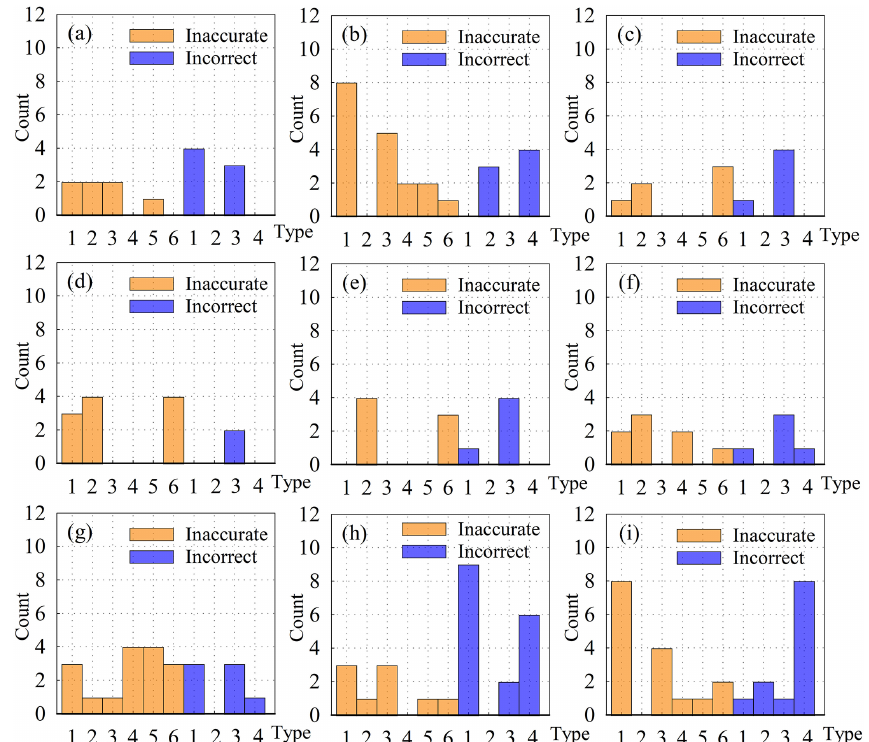
Figure 10. The statistical chart of evaluating results according to the second-level categories. Table 3. The rules of accuracy